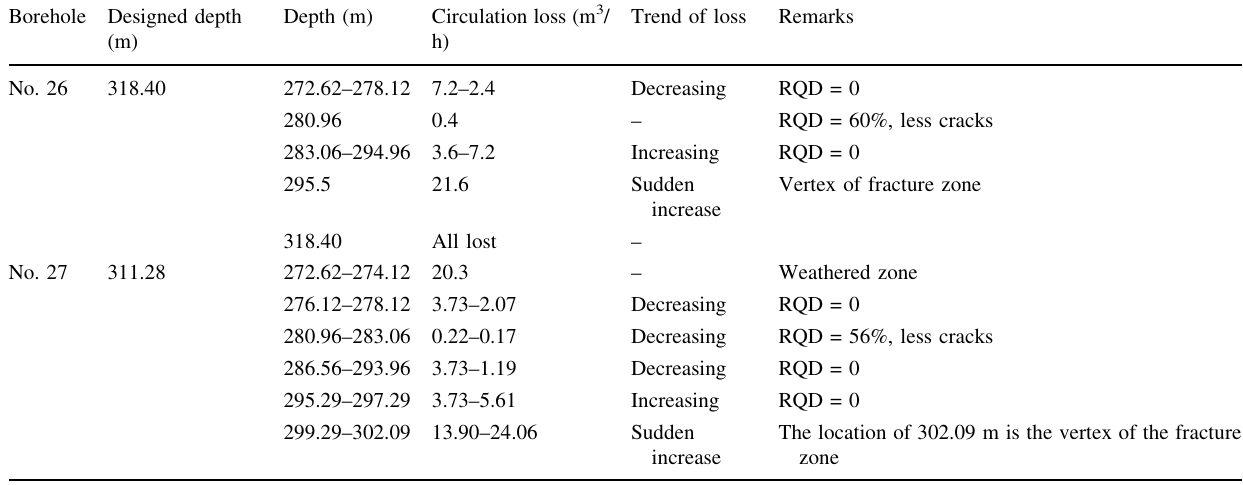
Table 3 Height observations during the drilling of boreholes Nos. 26 ad 27 Borehole Designed depth (m)